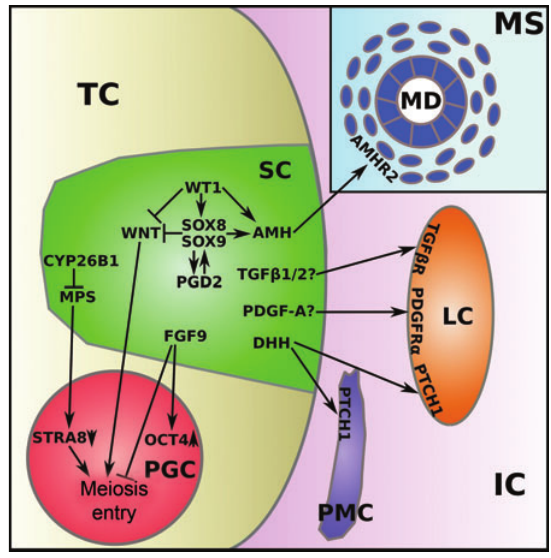
Figure 3 Central role of SCs in testis